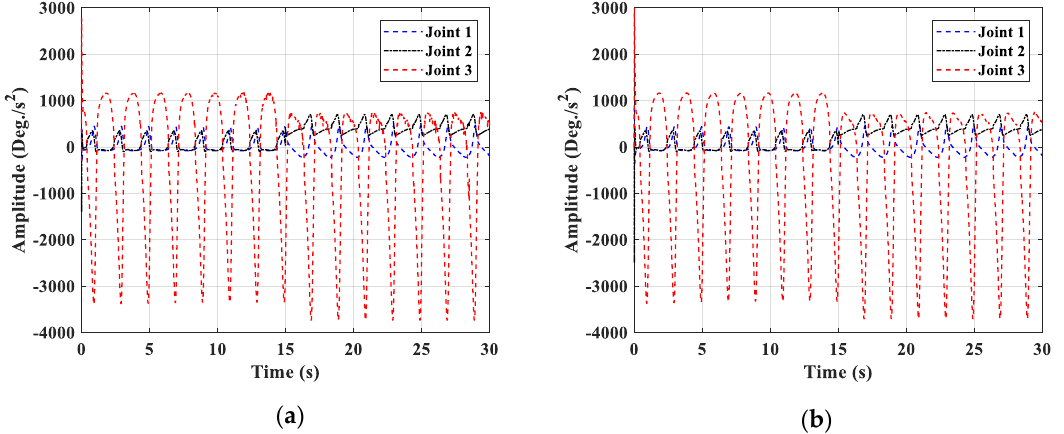
Figure 11. Lumped disturbance response of the planar manipulator at 0.5 Hz: ( a ) lumped disturbance and ( b ) estimated lumped disturbance.